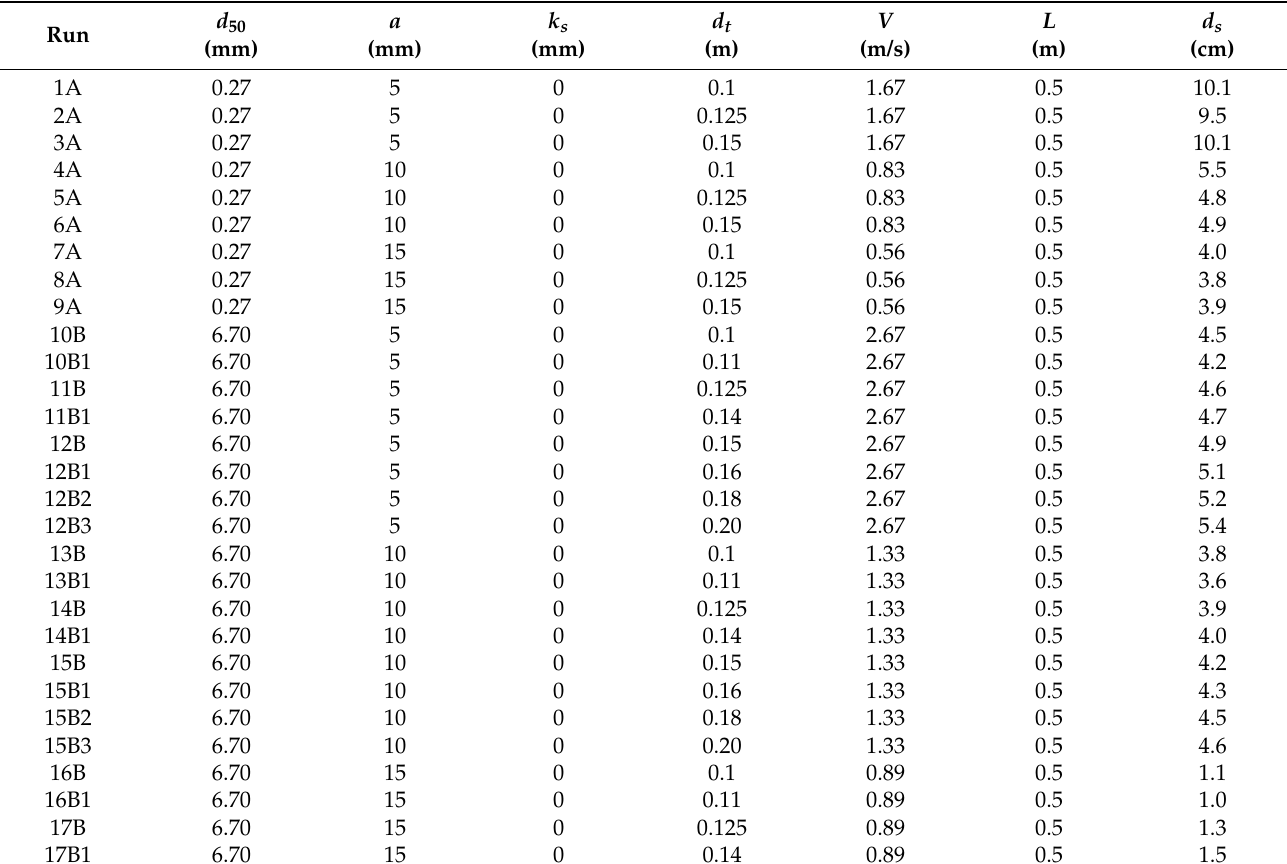
Table A1. Experimental data used in this